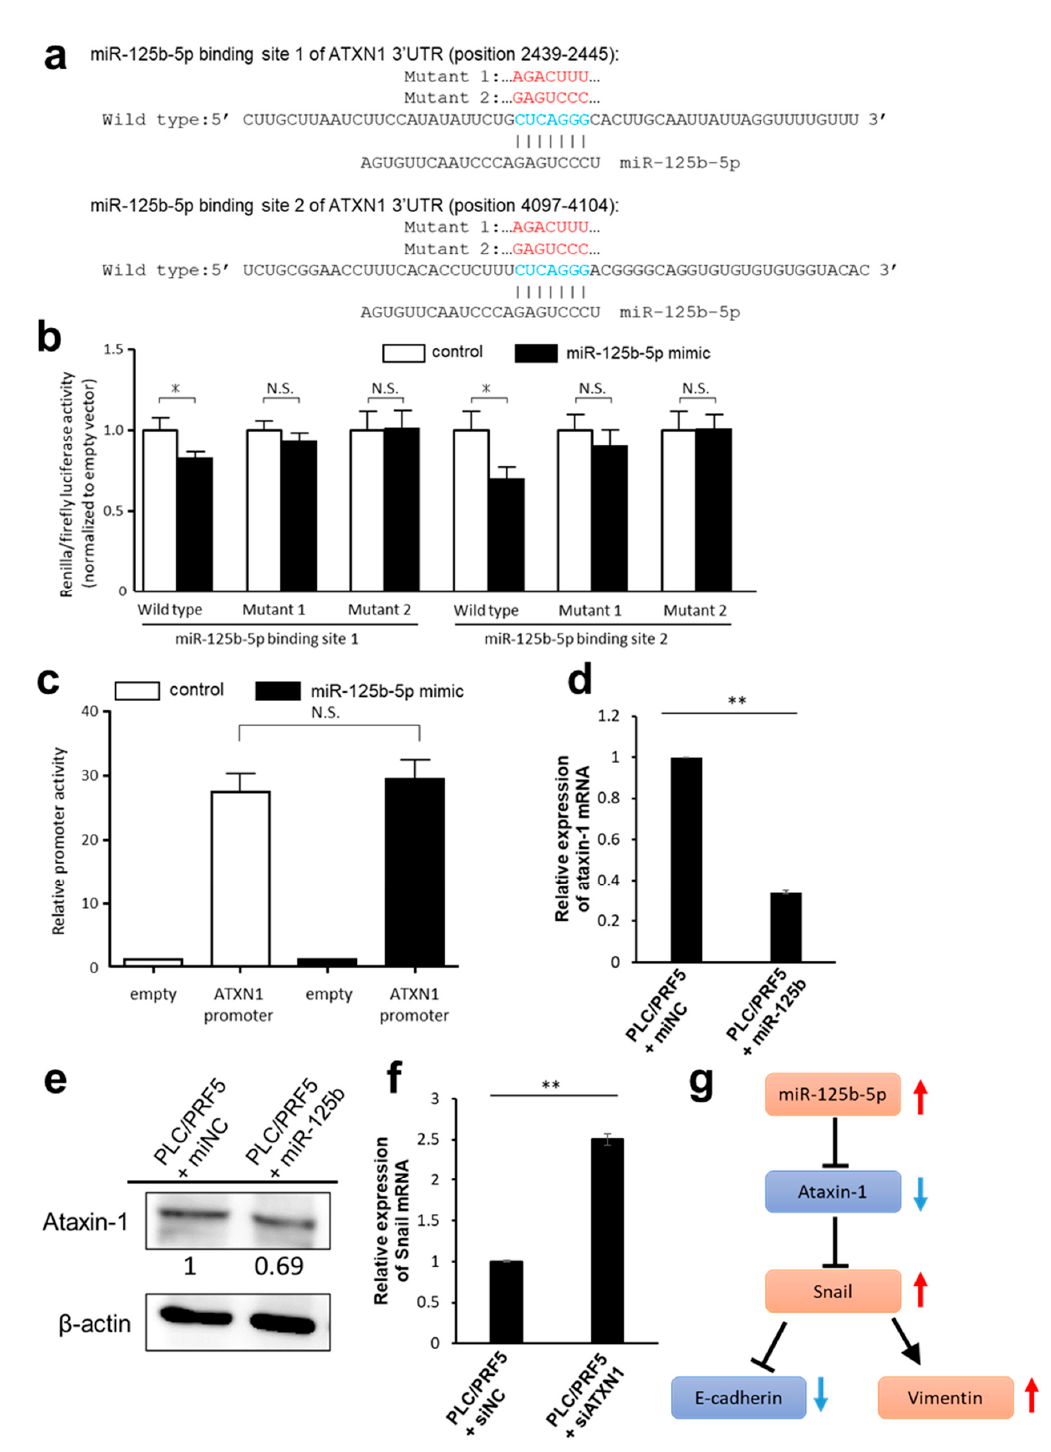
Figure 3. ATXN1 as a target gene of miR-125b-5p in HCC cells. ( a ) Target Scan predicted two putative binding sites of miR-125b-5p (position 2439-2445 and 4097-4104, shown in blue) in the ATXN1 3 ′ -UTR region. The mutated sequences (shown in red) of putative binding sites 1 and 2 are shown as ATXN1 3 ′ -UTR Mutant 1 or Mutant 2, respectively. The indicated sequences (Wild type and Mutant 1 and 2) of ATXN1 3 ′ -UTR were cloned to psiCHECK2 vector. ( b ) psiCHECK2 vectors containing the wild type or mutant sequences, or the empty vector were co-transfected with miR-125b-5p. Renilla luciferase activity was normalized to firefly luciferase. Fold-change values were normalized to empty vector and mimic